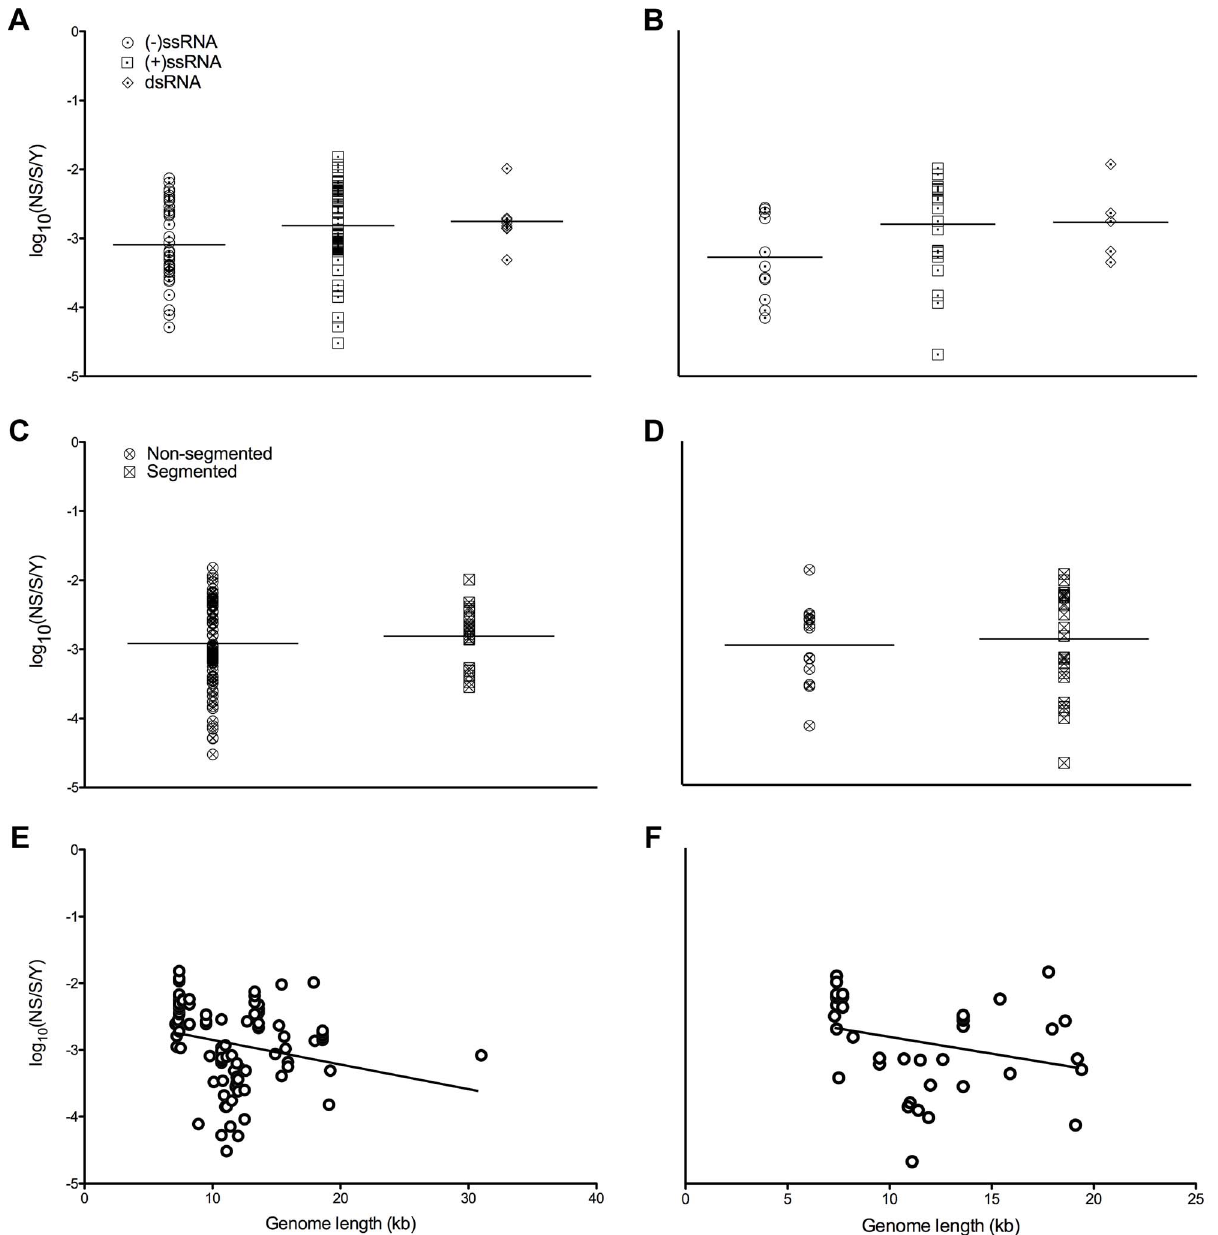
Figure 2. Nucleotide substitution rates and genomic properties of mammalian RNA viruses. Log scale mean substitution rate (log 10 (nucleotide substitutions/site/year, NS/S/Y)) estimates for different genomic architectures (sense/strandedness, A and B, and whether or not the genome is segmented, C and D) and plotted against genome lengths (E and F). The plots on the left show rates based on structural genes, while the plots on the right show those of non-structural genes. Each black bar in A–D indicates the mean of each level, and the levels of each of these variables are sorted by increasing mean substitution rate. The line of best fit is shown in E and F. The coefficients of determination ( R 2 ) for the linear regression models of genome lengths vs. substitution rates were 0.06 for the structural gene dataset and 0.08 for the non-structural gene dataset. Sources of the rates are given in Table S1.